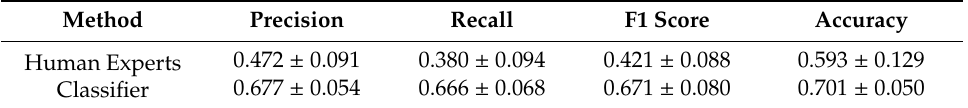
Table 1. Precision, recall, F1 score, and accuracy of human experts and AlexNet for classifying real images and generated images. We gathered statistics for 10 trainings, and the di ff erence was statistically significant ( p < 0.05).